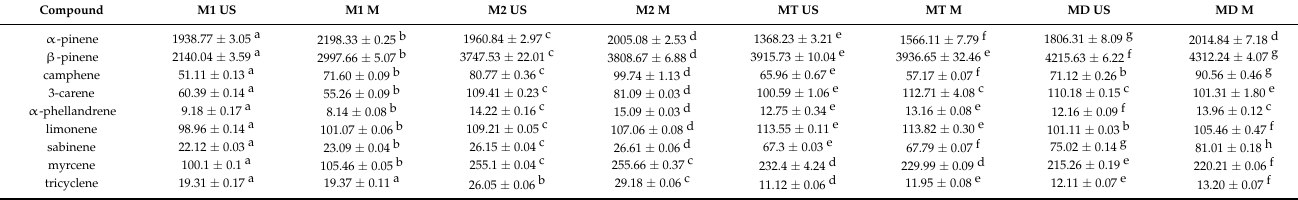
Table 1. Terpenoids present in the bark of P. abies (mean ± st. dev. µ g compound/g vegetal material). Compound